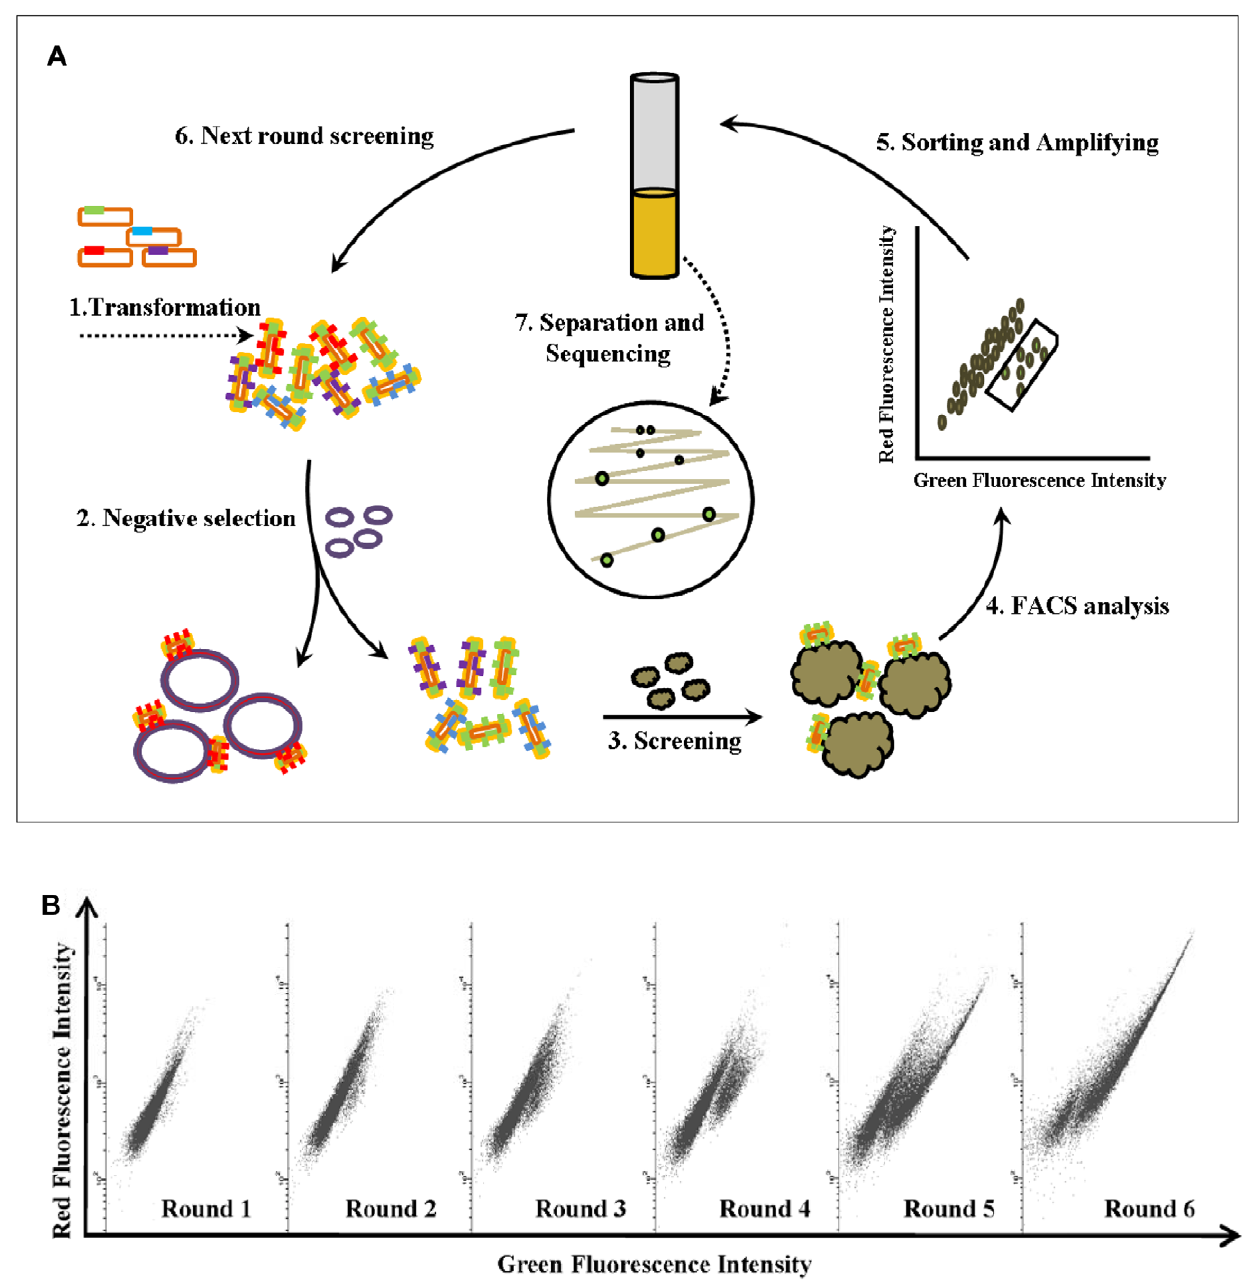
Figure 1. The process of screening and enriching the binding peptide library for cancer cells with bacteria surface display methods. ( A ) Schematic representation of peptides screening and selection with bacterial display library. 1. Constructed the library by transforming plasmids into E.coli MC1061; 2. Discarded the bacteria binding with normal cells after pre-incubation; 3. Incubated the mixture of cancer cells and residual bacteria; 4. Analyzed the binding effect of cancer cells with bacteria using FACS; 5. Sorted the binding bacteria to cancer cells by flow cytometry and cultured the binding bacteria in medium; 6. Performed the next round binding bacteria screening; 7. Isolated the binding bacteria to cancer cells and sequenced the peptides displayed on the surface of the bacteria. ( B ) The progress of enrichment of bacteria binding with cancer cells by FACS in 6 screening rounds.